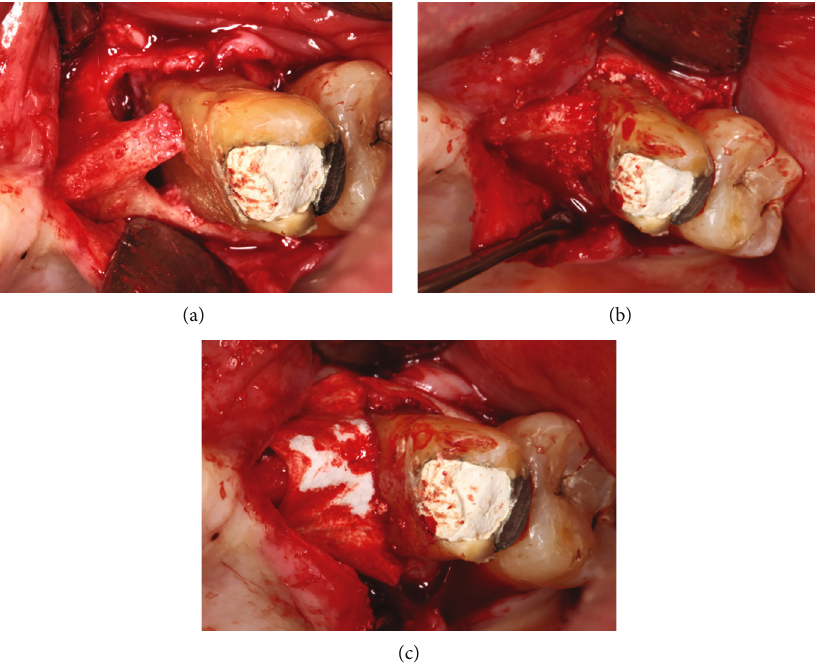
Figure 3: Guided tissue regeneration (GTR). (a) Infrabony defect on the mesial and buccal part of tooth #26, with some bone holding the middle third of the mesial root. (b) Packing of defect with a combination of allograft/alloplastic bone graft. (c) Pericardium membrane was placed over the